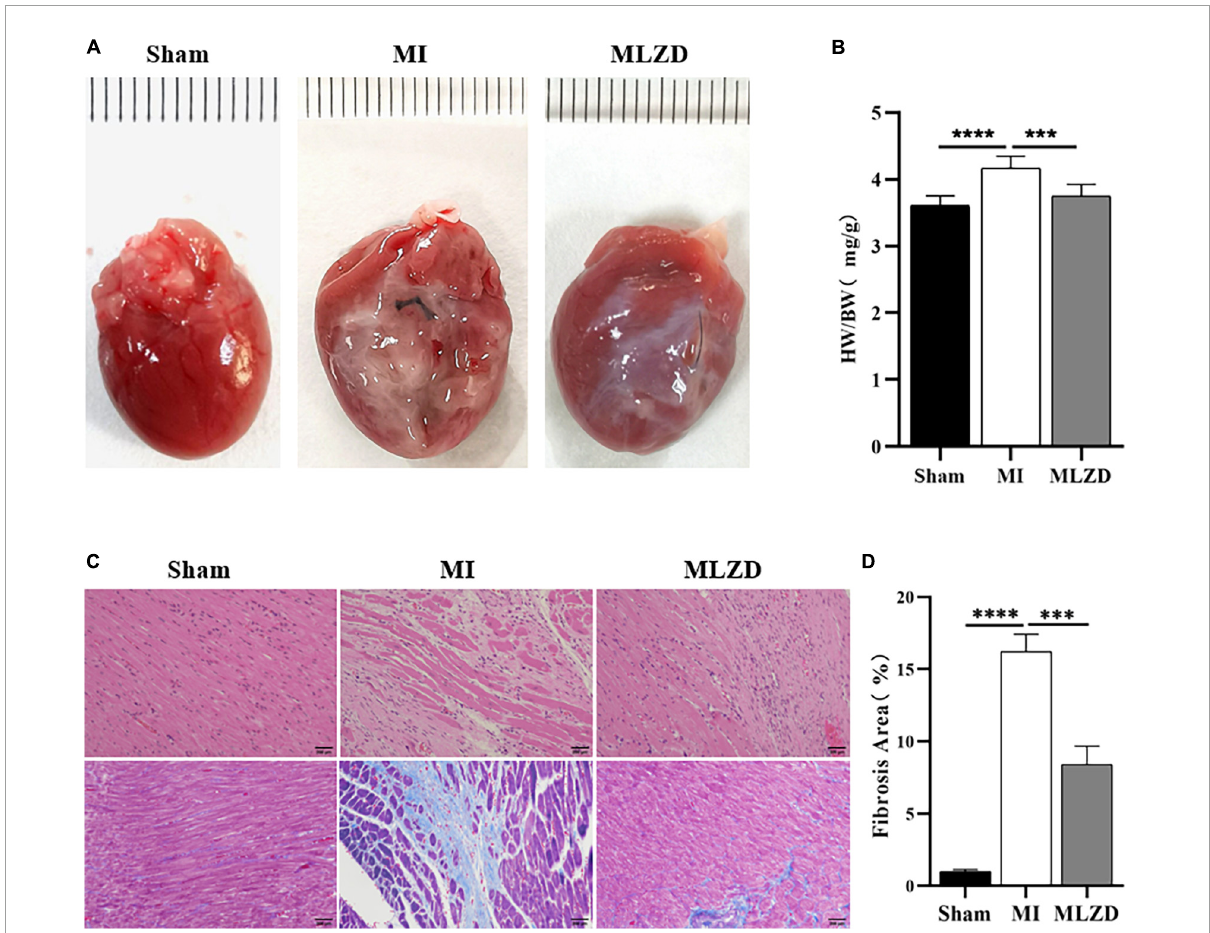
FIGURE3 Modified Linggui Zhugan Decoction (MLZD) ameliorated cardiac fibrosis and reversed ventricular remodeling. (A) The appearance of hearts in three groups. (B) Ratios of heart weight to total body weight. (C) Representative images of HE and Masson trichrome staining, scale bar = 200 µ m. (D) Quantification of myocardial fibrosis by fibrosis area, n = 3 per group. Data are presented as mean ± standard deviation ( x ± s); ∗∗∗ P < 0.001, ∗∗∗∗ P <